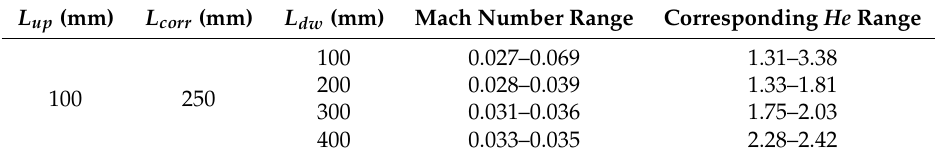
Table 4. Mach number and corresponding Helmholtz number ( He ) range for pipe systems in Case a-I. L up (mm)